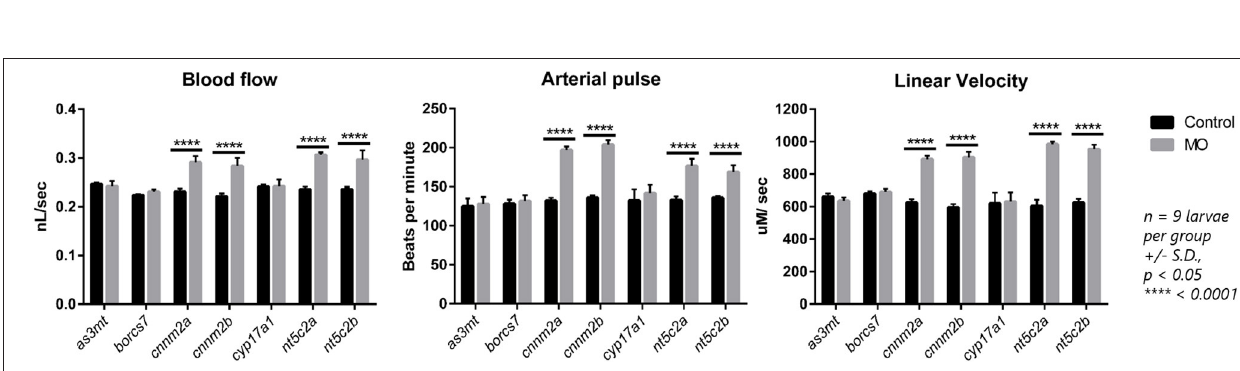
at 72 hpf by measuring relative gene-expression levels